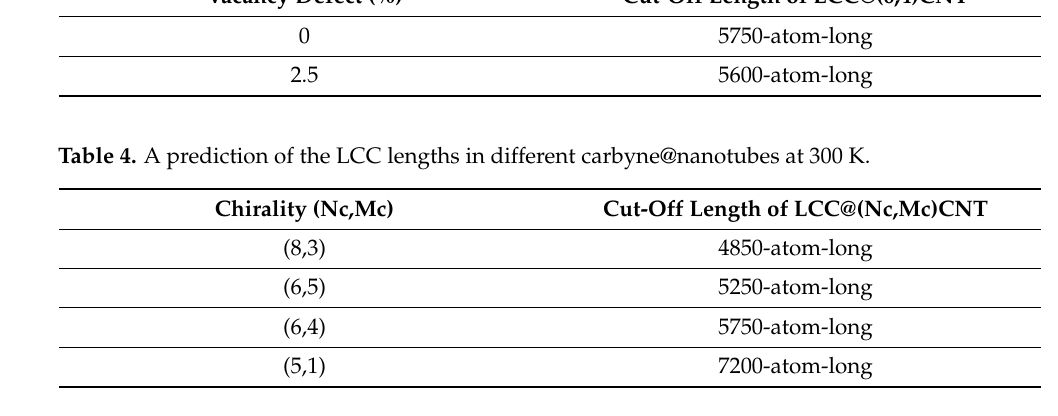
Table 5. The predicted cut-off lengths of the LCC in a (6,4)CNT at different temperatures. Cut-Off Length of